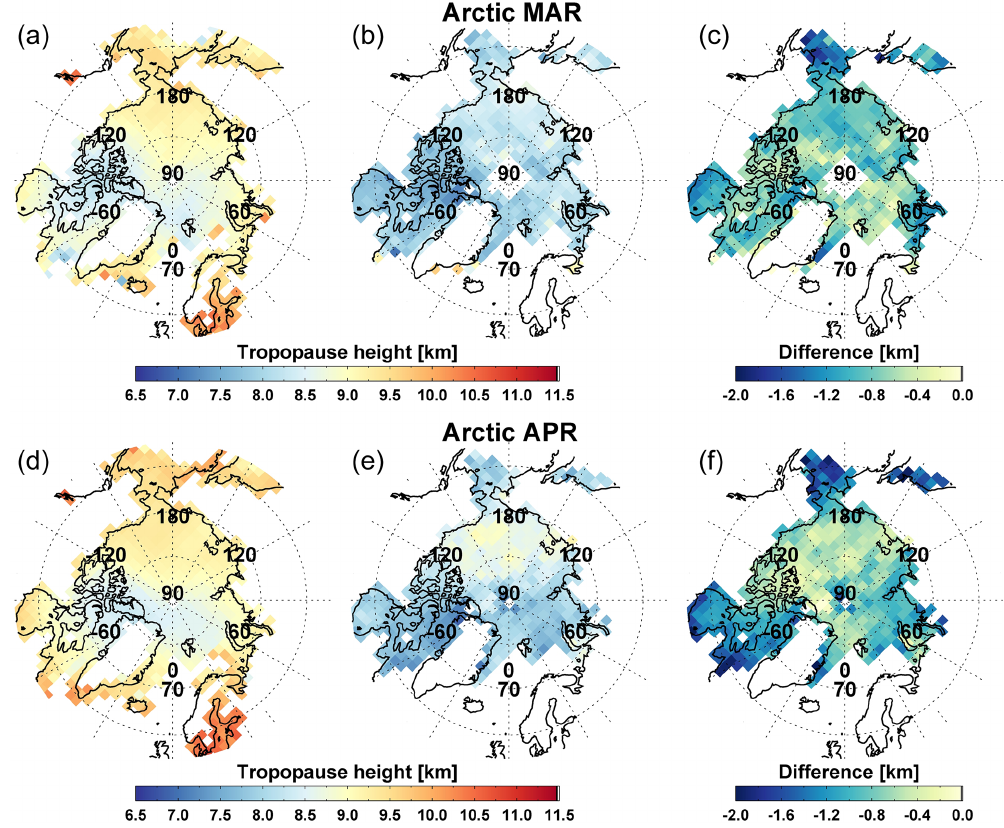
Figure 18. Monthly tropopause height for the mean field (a, d) , the enhanced BrO case (b, e) , and tropopause anomalies (difference of tropopause height between the enhanced BrO case and the mean field) (c, f) over the Arctic in March (a–c) and April (d–f)